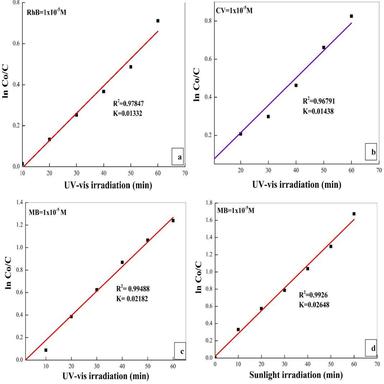
Pseudo-first-order kinetics for (a) RhB, (b) CV and (C) MB under UV–vis irradiation (d) MB under Sunlight irradiation.